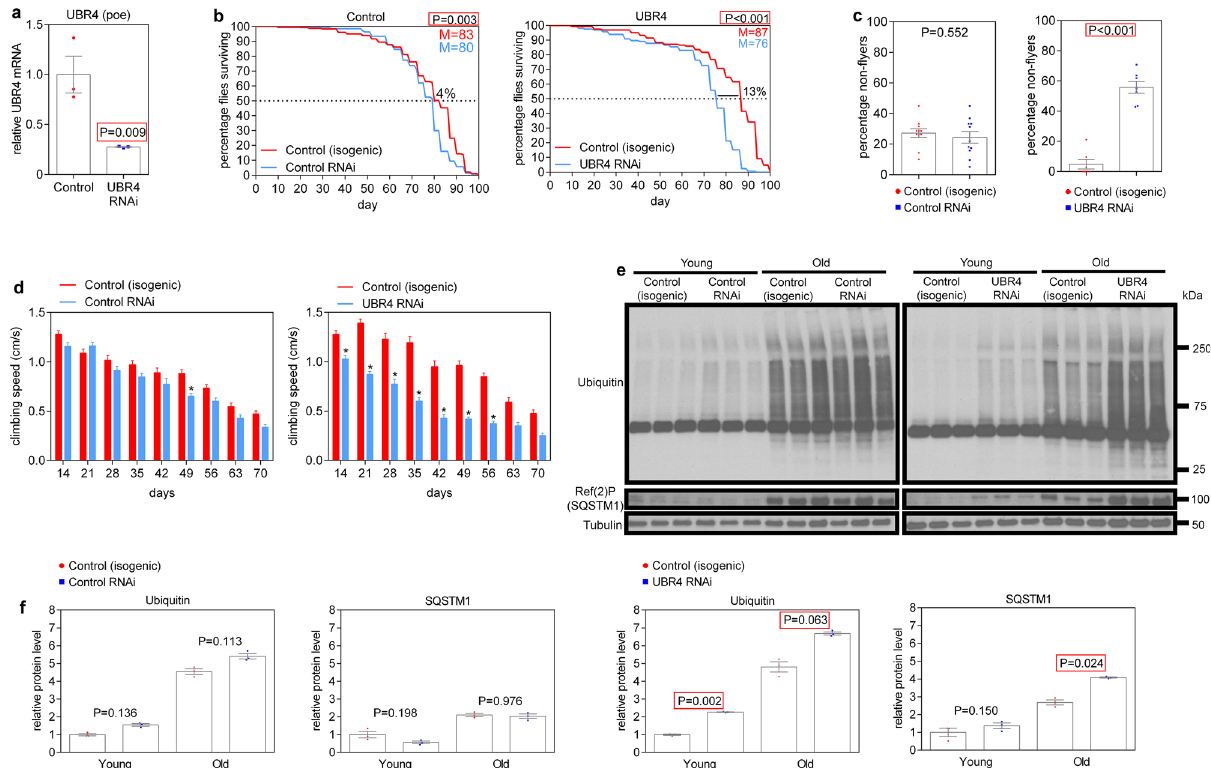
Fig. 5 Muscle-speci fi c loss of UBR4 compromises protein quality control and muscle function and shortens lifespan in Drosophila . a UBR4 knockdown measured by qRT-PCR from thoraces with UBR4 RNAi driven by the adult muscle-speci fi c MHC(F3.580)-GAL4 . b UBR4 loss in adult Drosophila muscle reduces the median lifespan by ~13% compared to isogenic controls whereas control RNAi has minimal effects (~4% reduction). In response to muscle- speci fi c UBR4 loss, decreased muscle function was also observed, as indicated by the c fl ying ability and the d climbing speed. e Detergent-insoluble protein extracts showed increased levels of ubiquitin and Ref(2)P ( Drosophila SQSTM1) in skeletal muscle with UBR4 knockdown. f Quanti fi cations demonstrate compromised protein quality control in response to UBR4 loss; * indicates P < 0.05. In a , f n = 3 biological replicates, each consisting of 10 thoraces. In b , d n > 100 fl ies per group were used for the longitudinal survival and climbing speed analysis (speci fi c P and n values are reported in the Source Data fi le). In c the percentage of fl ies not fl ying was determined for each individual tube of fl ies (each tube with ~20 fl ies), with n (control RNAi) = 10 and n (UBR4 RNAi) = 7. Data are presented as mean ± SEM. In a , c two-tailed Student ’ s t -test was used. In b the OASIS2 webtool and log-rank tests were used for the statistical analysis of lifespan. In d , f statistics were calculated by using two-way ANOVA with Bonferroni ’ s post hoc test with adjustment for multiple comparisons. Similar results were obtained from two independent sets of biological